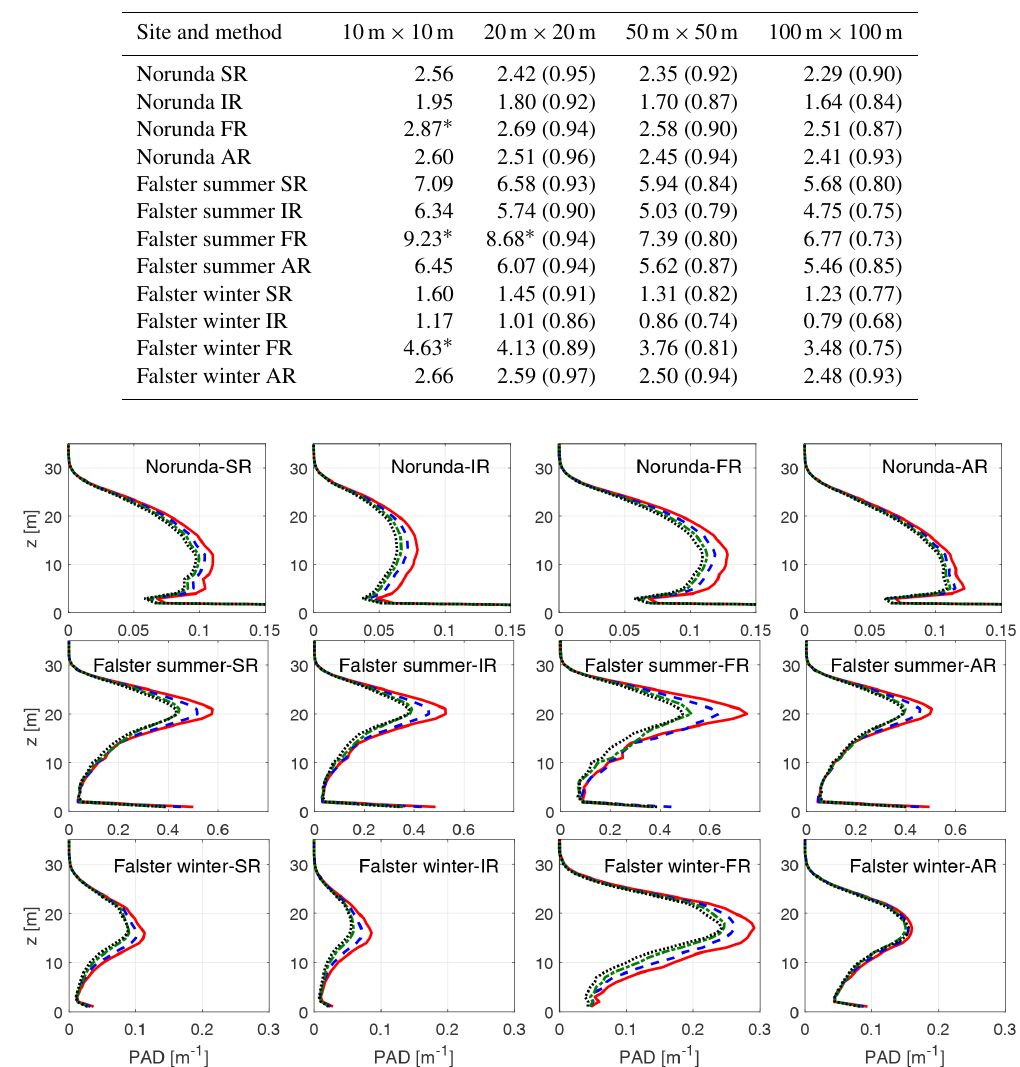
Table 3. Values of the average PAI for the two sites, using different calculation methods and grid resolutions. ∗ A number of PAD estimates were not possible due to fully attenuated first returns before ground level. The data were filled with PAD values of 0.1. Less than 1% of the estimates were affected except for Falster summer at a resolution of 10m × 10m, where 4% were affected.